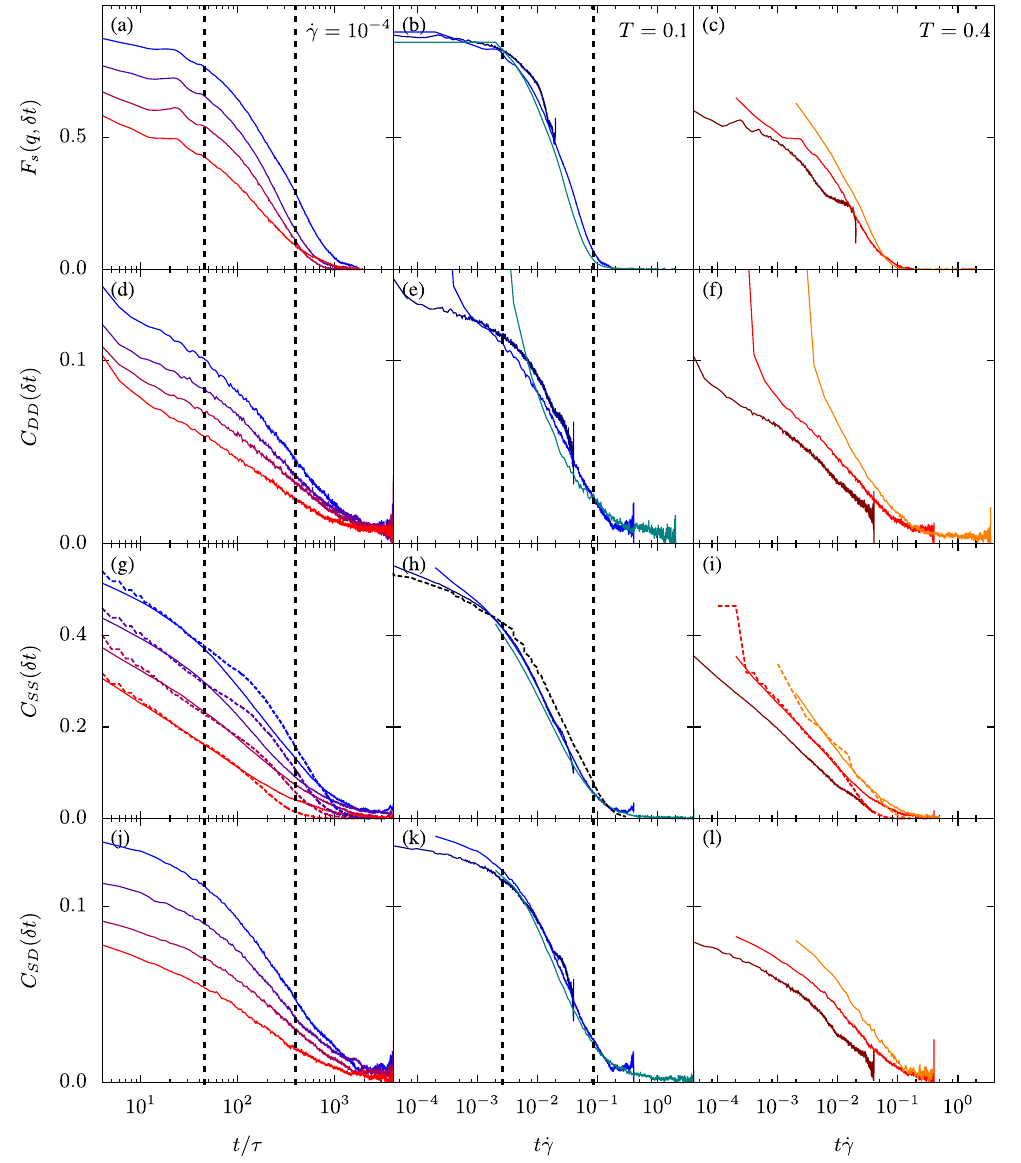
FIG. 5. Correlation functions of the D 2 field and the soft-spot population. On the left are comparisons of the temperatures min considered from T ¼ 0 . 1 (in blue) to T ¼ 0 . 4 (in red) at a strain rate of _ γ ¼ 10 − 4 . In the middle column are comparisons of the strain rates considered from _ γ ¼ 10 − 5 (in dark blue) to _ γ ¼ 10 − 3 (in green) scaled by the strain rate, t= τ → _ γ t at a temperature T ¼ 0 . 1 . On the right are comparisons of the strain rates considered from _ γ ¼ 10 − 5 (in brown) to _ γ ¼ 10 − 3 (in yellow) scaled by ; t Þ the strain rate, t= τ → _ γ t at a temperature T ¼ 0 . 4 . Figures (a) – (c) show the self-intermediate scattering function F ð q max ˆ y . Figures (d) – (f) show the autocorrelation function for D 2 . Figures (g) – (i) show the autocorrelation evaluated at q ¼ 2 π = σ AA min function for the soft-spot population. In (g), at each temperature, comparisons are made with the cumulative probability density function for individual soft-spot lifetimes, introduced in Sec. V, overlaid in dashed lines. In (h), a single comparison is made to ≥ δ t Þ , shown using a dashed black line, for lifetimes aggregated from lifetimes collected at all three different strain rates. In P ð τ L (i), predictions from the cumulative probability density function for individual soft-spot lifetimes are shown for the two faster strain rates overlaid in a dashed line. Figures (j) – (l) show the cross correlation between D 2 and the soft-spot population. The min plots in both the middle and left columns feature two vertical dashed lines to serve as guides to the eye. The earlier line occurs at a time τ (cid:2) when the self-intermediate scattering function first drops below the plateau. The later line occurs at the relaxation time τ α ; τ α Þ ∼ e − 1 defined so that F ð q max